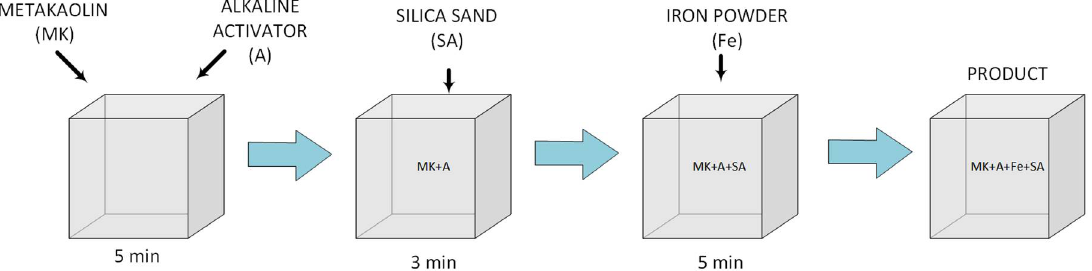
Figure 3. The preparation process of the modified geopolymers.